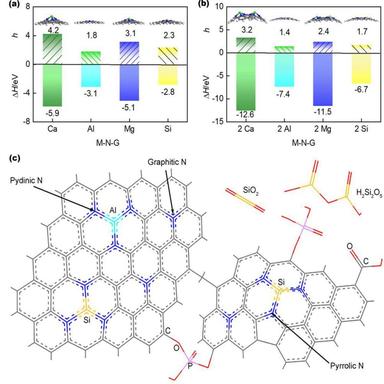
Comparison of lattice deformation, h and degree of stabilisation, DH, calculated by DFT for various M-N-G structures with: (a) one metal doped N-G and (b) two metal doped N-G. (c) Schematic illustration of the char layer structure derived from Binder-IFR-MMT. (A colour version of this figure can be viewed online.)